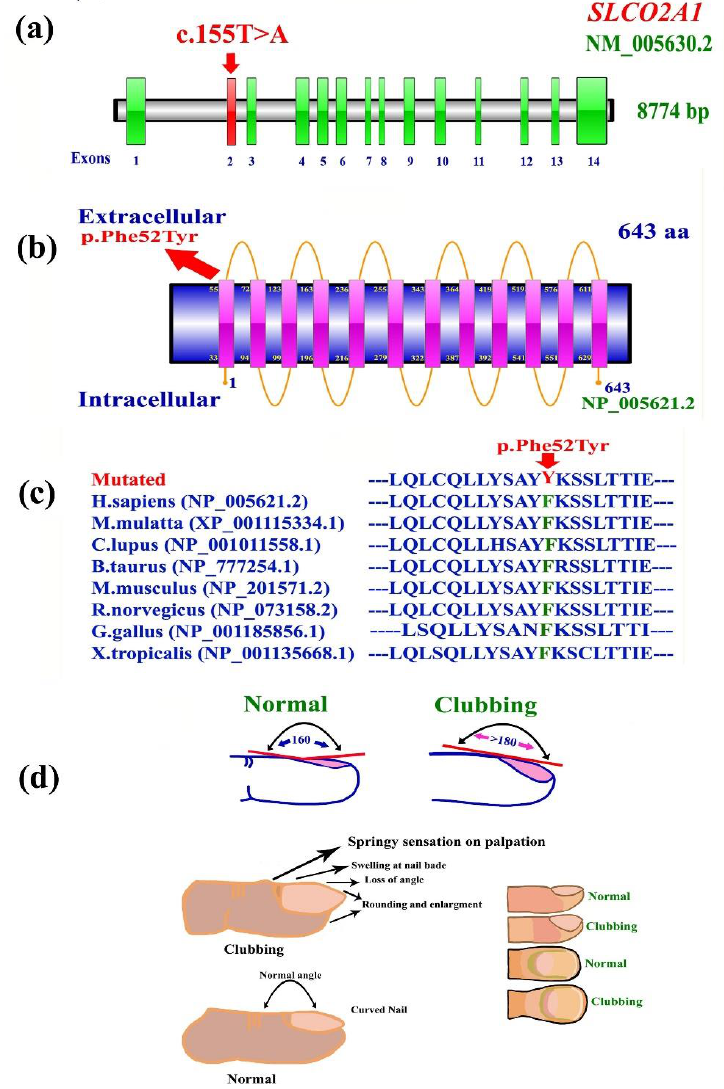
Figure 2. ( a ) SLCO2A1 gene showing 14 coding exons, and position of mutation identified in the present study. ( b ) Cartoon model of prostaglandin transporter (SLCO2A1, PGT), position of identified mutation. PGT is an integral membrane protein with 12 transmembrane domains. Homozygous missense mutation Phe52Tyr is located within the first transmembrane domain of the protein. ( c ) Phe52 amino acid conservation across different species. ( d ) Cartoon representation of normal nail and nail clubbing.